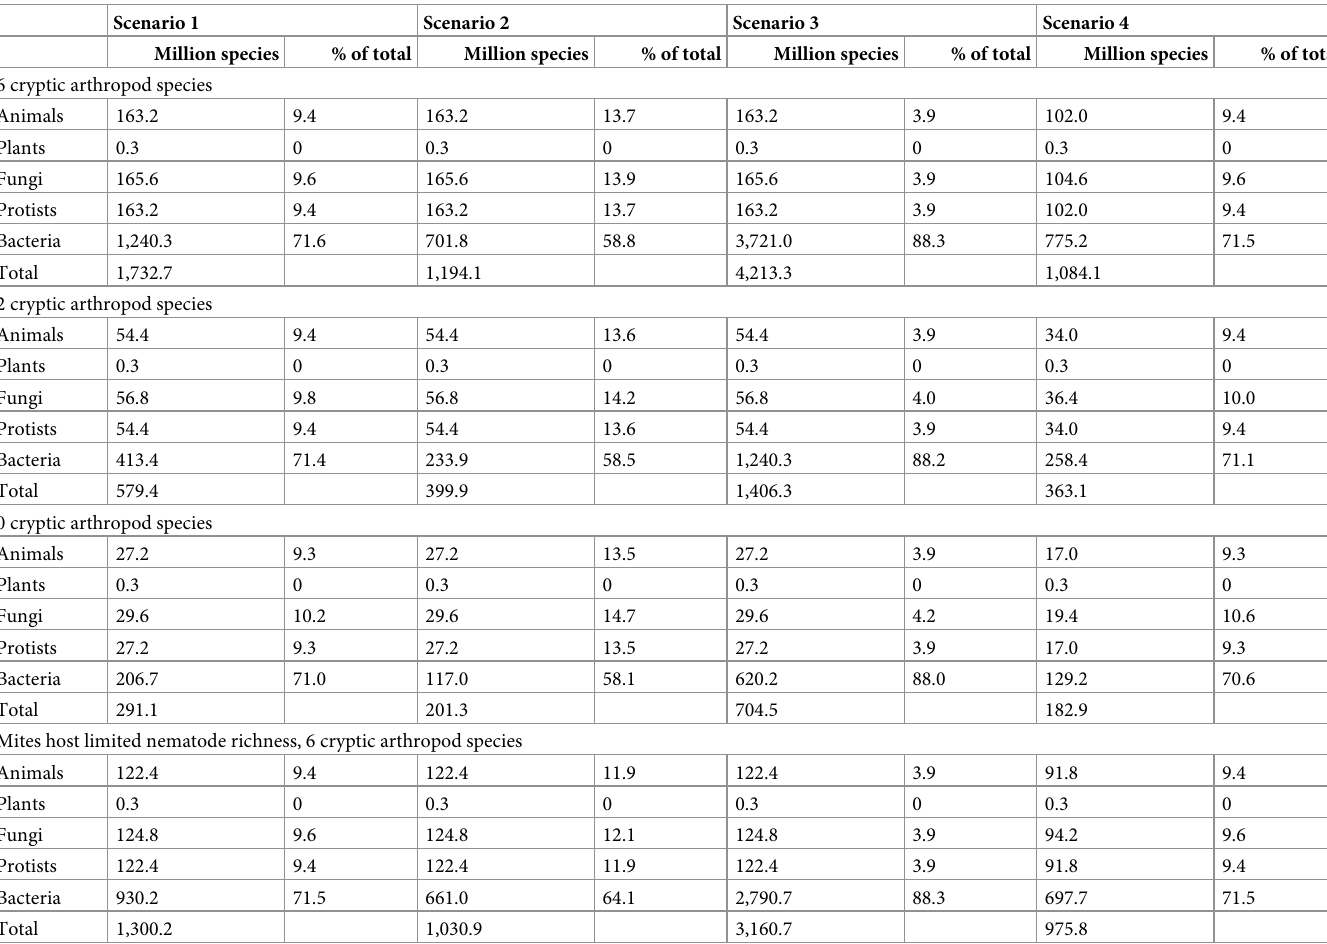
Table 2. Modified projections of global species richness across major groups of organisms. These projections are based on refined estimates of host-specific bacterial richness (details in S3 Text). The 4 scenarios follow Larsen and colleagues [2] and are explained below. For each scenario, the projected number of species for each group is shown, along with the percentage of the total number of species belonging to that group (note that plants are < 0.5% and are rounded down to 0%). In addition to the 4 sce- narios, 4 other assumptions were explored. The first 3 involve different estimated numbers of morphologically cryptic arthropod species per morphology-based insect spe- cies (from 6 to 2 to 0; for justification, see [2]). These impact the number of animal species, and all downstream estimates for other groups. The final, fourth set of analyses assumes 6 morphologically cryptic arthropod species and that mites host negligible numbers of nematode species. Scenario 1 assumes that all animal species have a full set of bacterial, protist, and fungal endosymbionts, even if they are parasites, but that microsporidian fungi and apicomplexan protists have little or no host-specific bacterial richness. Scenario 2 assumes that symbionts have limited numbers of symbionts themselves (i.e., nematodes have an average of only one host-specific bacterial species) and that microsporidians and apicomplexans have few or no bacterial species. Scenario 3 assumes that all animal species have a full set of symbiont species and that micro- sporidians and apicomplexans host (on average) as many bacterial species as animal species do. Scenario 4 is identical to Scenario 1, except that it assumes that mites have reduced species richness relative to other arthropods (0.25 mites1 other arthropod species). Note that there is an error in Table 3, Scenario 1 in Larsen and colleagues [2]: There should be 27.2 million animal species, not 20.4. The correct number is used here. Archaean species is considered to be limited overall [2], and so is not treated